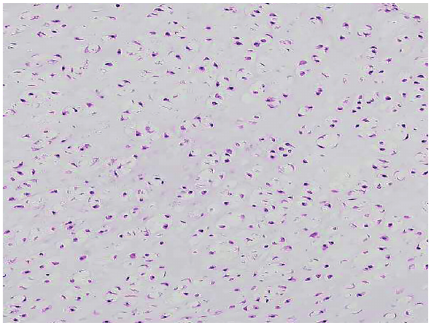
Figure 5: Histological finding of periosteal chondroma. The tumor is composed of bland chondrocytes in an abundant hyaline cartilage